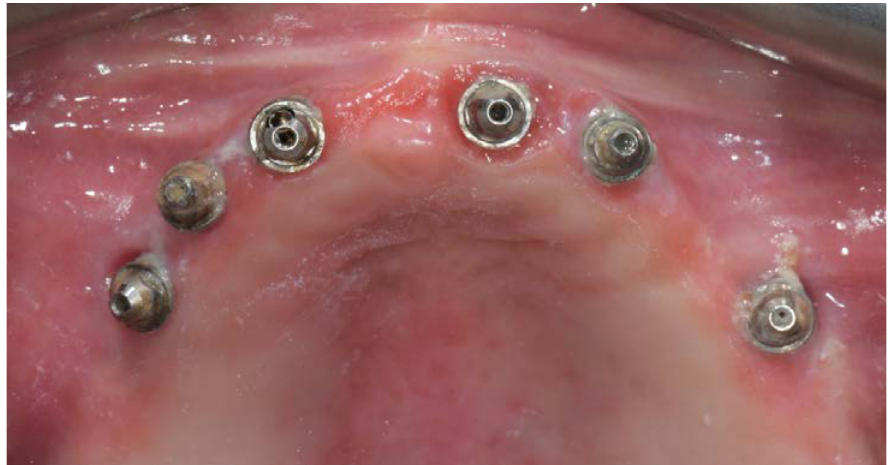
Figure 4. Radiographic status of the previous restoration.